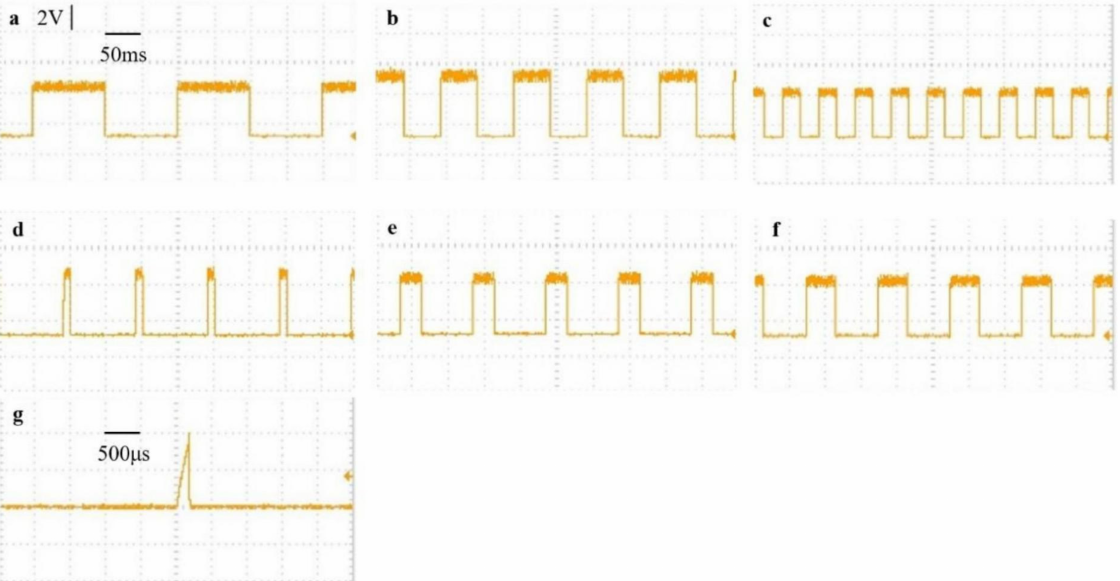
Figure 8. The stimulus signal of different parameters: ( a – c ) the stimulus signal of different frequencies: 20 Hz, 10 Hz, 5 Hz; ( d – f ) the stimulus signal of different duty cycles:10%, 20%, 40%; ( g ) the minimum pulse width is about 200 µ s when the duty cycle is 0.01.